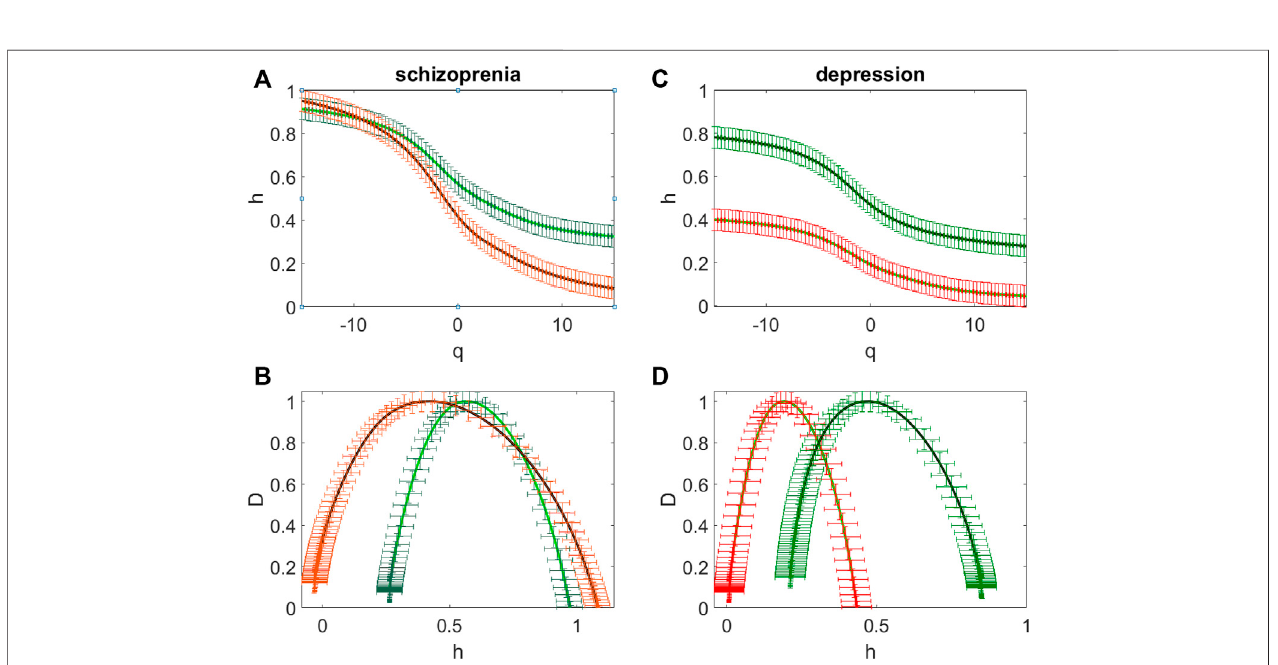
FIGURE 4 | The averaged dependences h ( q ) of the Hölder exponent on the power q value (A,C) and the averaged singularity spectra (B,D) for the patient with schizophrenia (A,B) and for the patient with depression (C,D) . The sites over the frontal and central regions (F3, Fz, F4, C3, C4) (green curves) and the sites over the occipital (O1 and O2), parietal (P3, P4, Pz) and temporal (T5 and T6) regions (red curves).